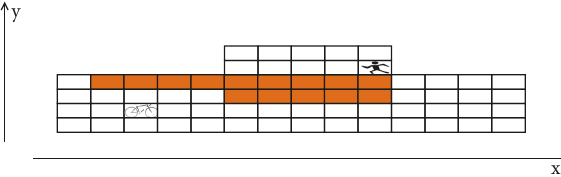
Figure 6: The influencing area of a pedestrian on bicycle